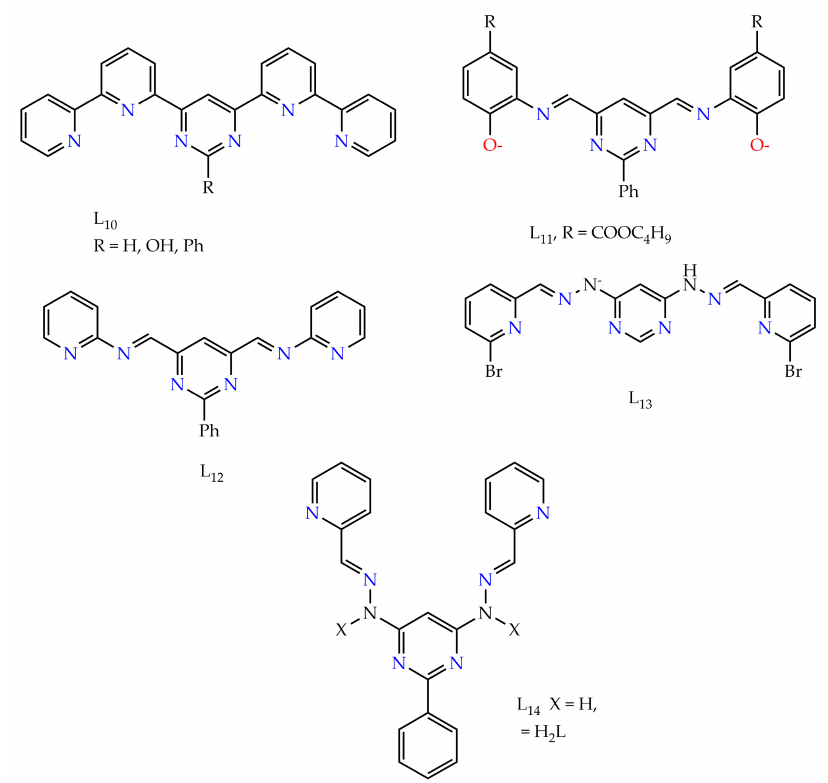
Chart 2. The three bis-terdentate ligands known to form SCO-active Fe 4 L 4 grids. All ligands provide N 6 and N 4 O 2 donor sets to the octahedral iron(II) centers.